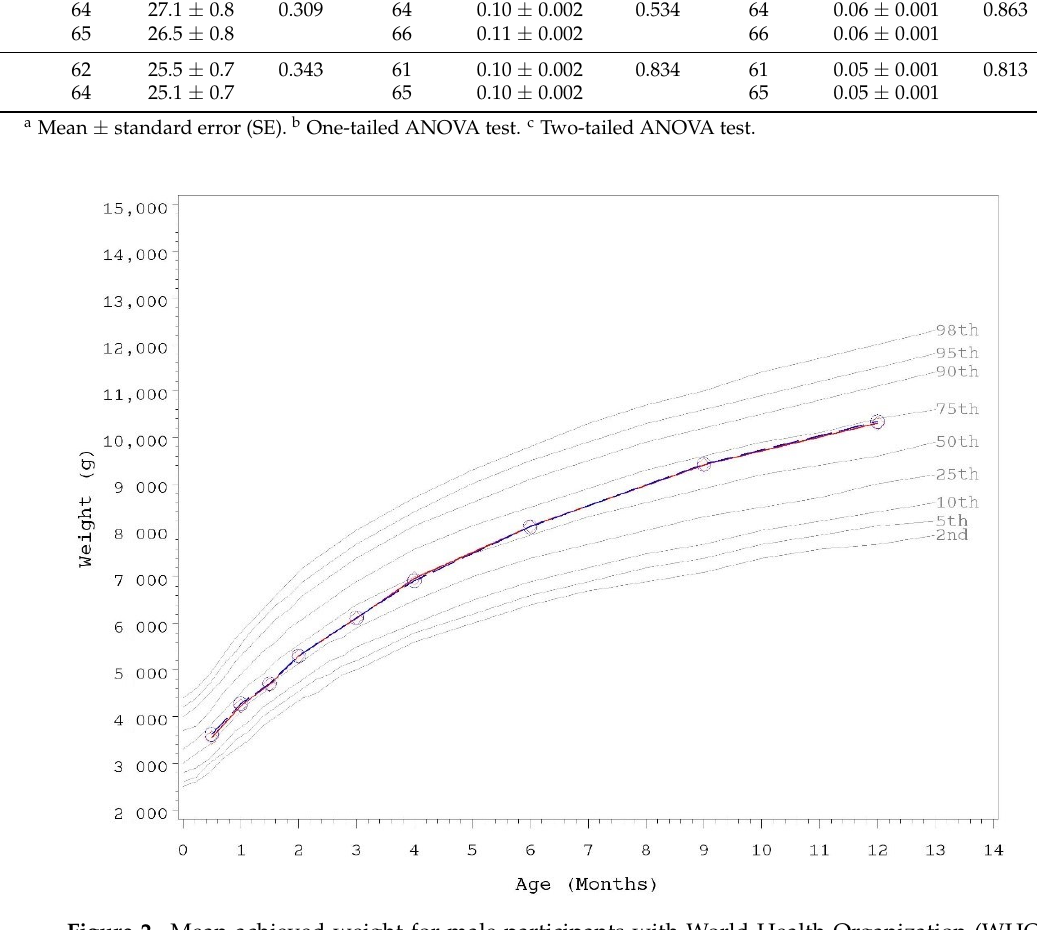
Figure 2. Mean achieved weight for male participants with World Health Organization (WHO) reference percentiles (2nd to 98th) through 12 months (days 14 to 365) of age. Control, red diamonds; INV-MFGM, blue circles. No statistically significant group differences by two-tailed ANOVA test.